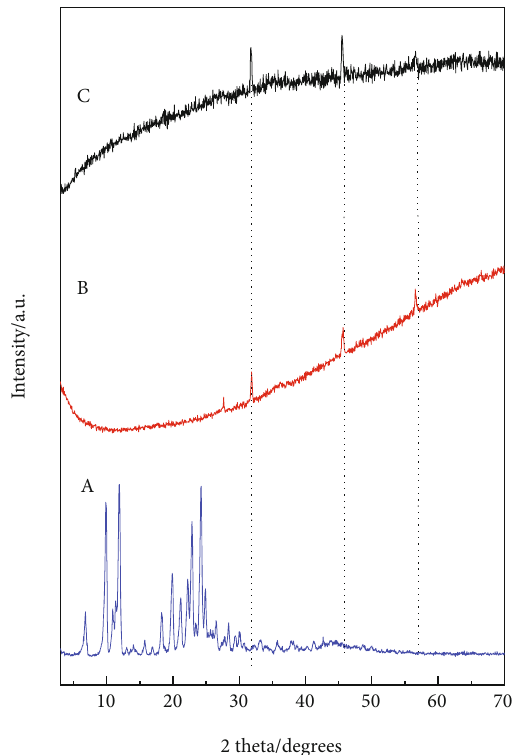
Figure 7: FTIR spectrum of (a) amlodipine, (b) polymer, and (c) Amlop-polymer